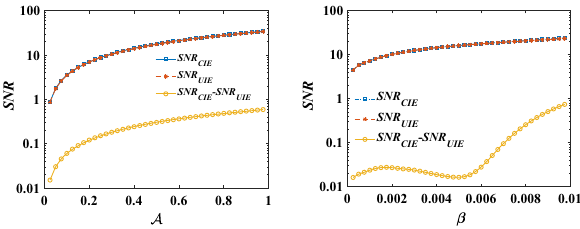
Fig. 5 The Signal to Noise Ratio of the CIE and UIE model, in the left panel we fixed β = 0 . 006 s, (cid:3) t echo = 0 . 0295 s, r = 0 . 15, and t echo = 0 . 0295 s and in the right panel we fixed A = 0 . 5, (cid:3) t echo = 0 . 0295 s, r = 0 . 15, and t echo = 0 . 0295s